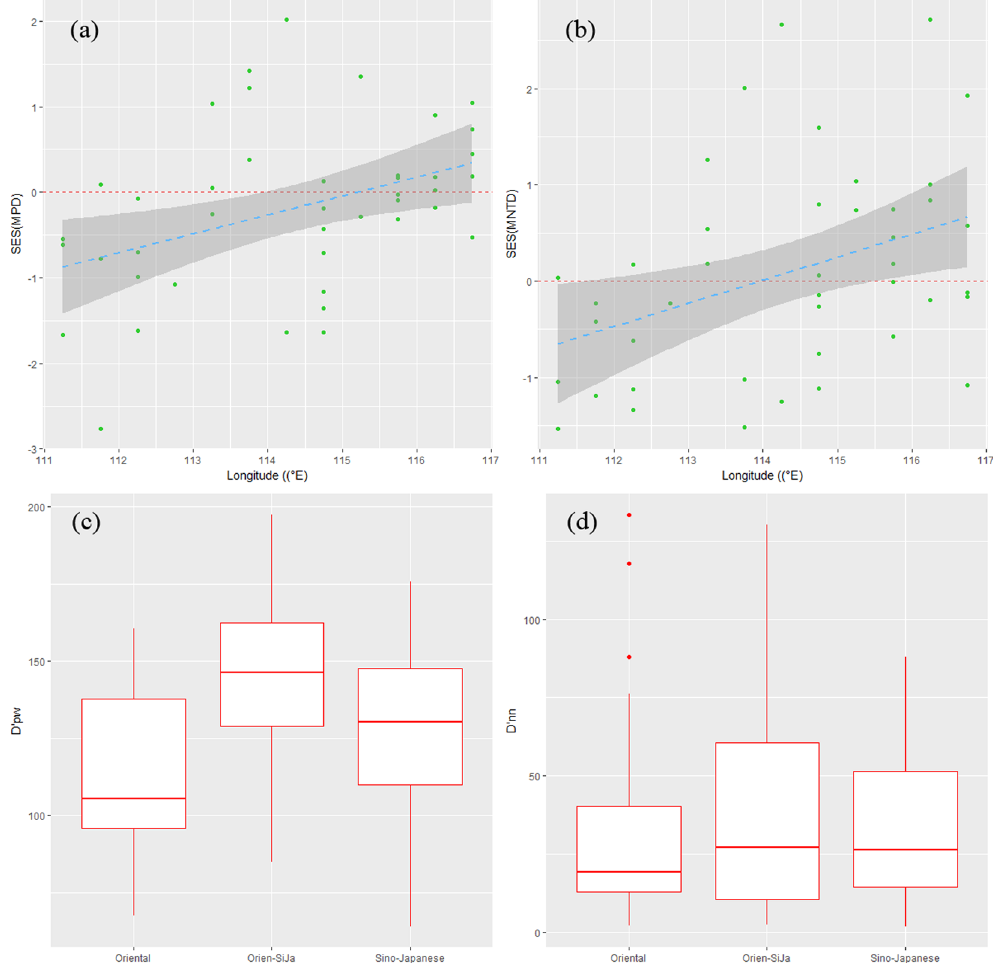
Figure 1. Patterns of phylogenetic structure for wintering waterbirds across geographical regions. ( a ) SES (MPD) and ( b ) SES (MNTD) beinging clustered at western zone (111°00 ′ –112°59 ′ ) and overdispersion at eastern zone (115°00 ′ –116°59 ′ ), fitted by GLM. ( c ) D ′ pw at the western zone being significantly lower than the eastern zone ( P adj < 0.01 and (d) D ′ nn at the western zone being lower than the eastern zone ( P adj =